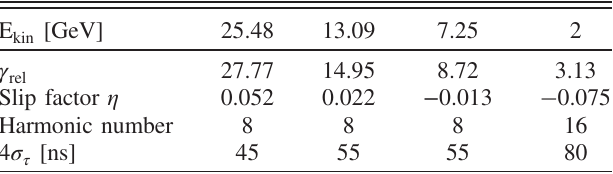
TABLE I. Beam parameters for vertical tune shift measure- ments at different